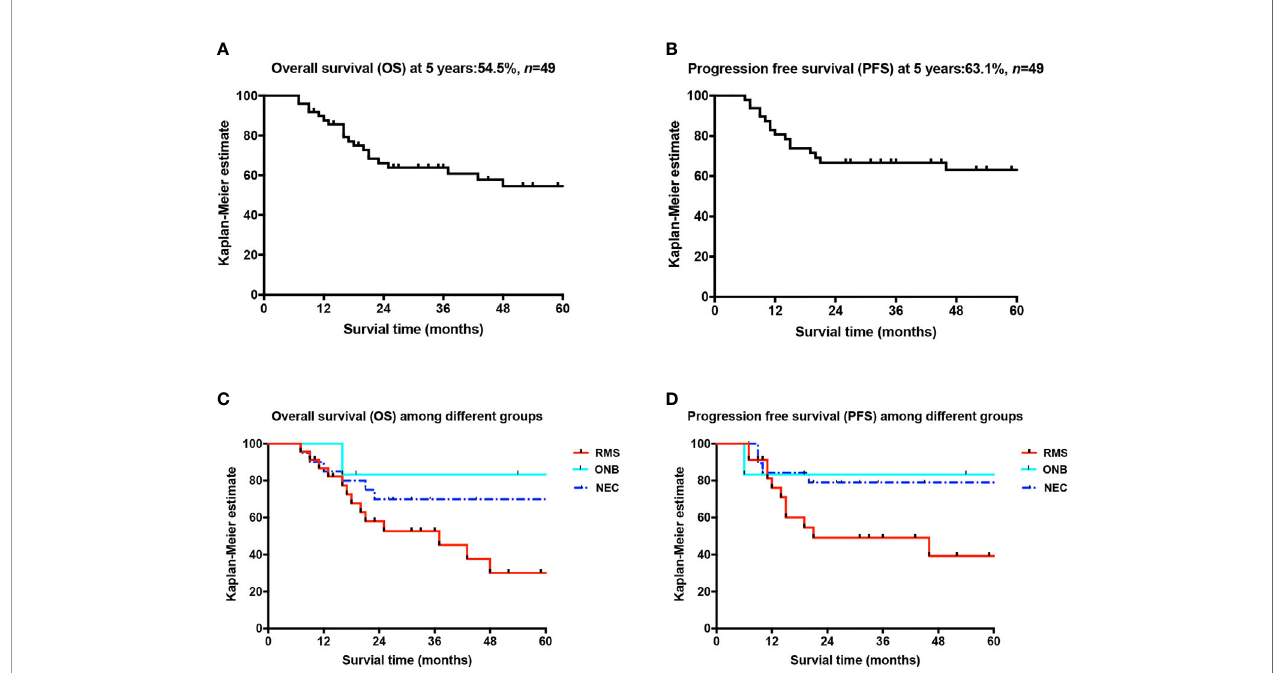
FIGURE 3 | Overall survival curves of patients and comparison curves of different pathological types. (A) Overall survival curve; (B) progression-free survival curve; (C) comparison of the OS curves of the three pathological types; (D) comparison of the PFS curves of the three pathological types.